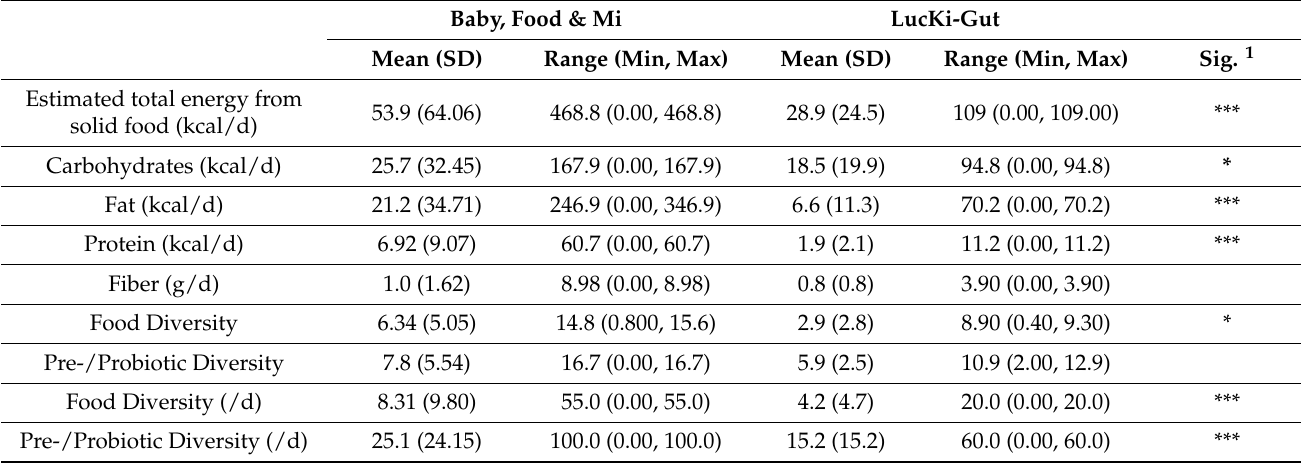
Table 2. Overview and comparison of the average nutritional intake over the study